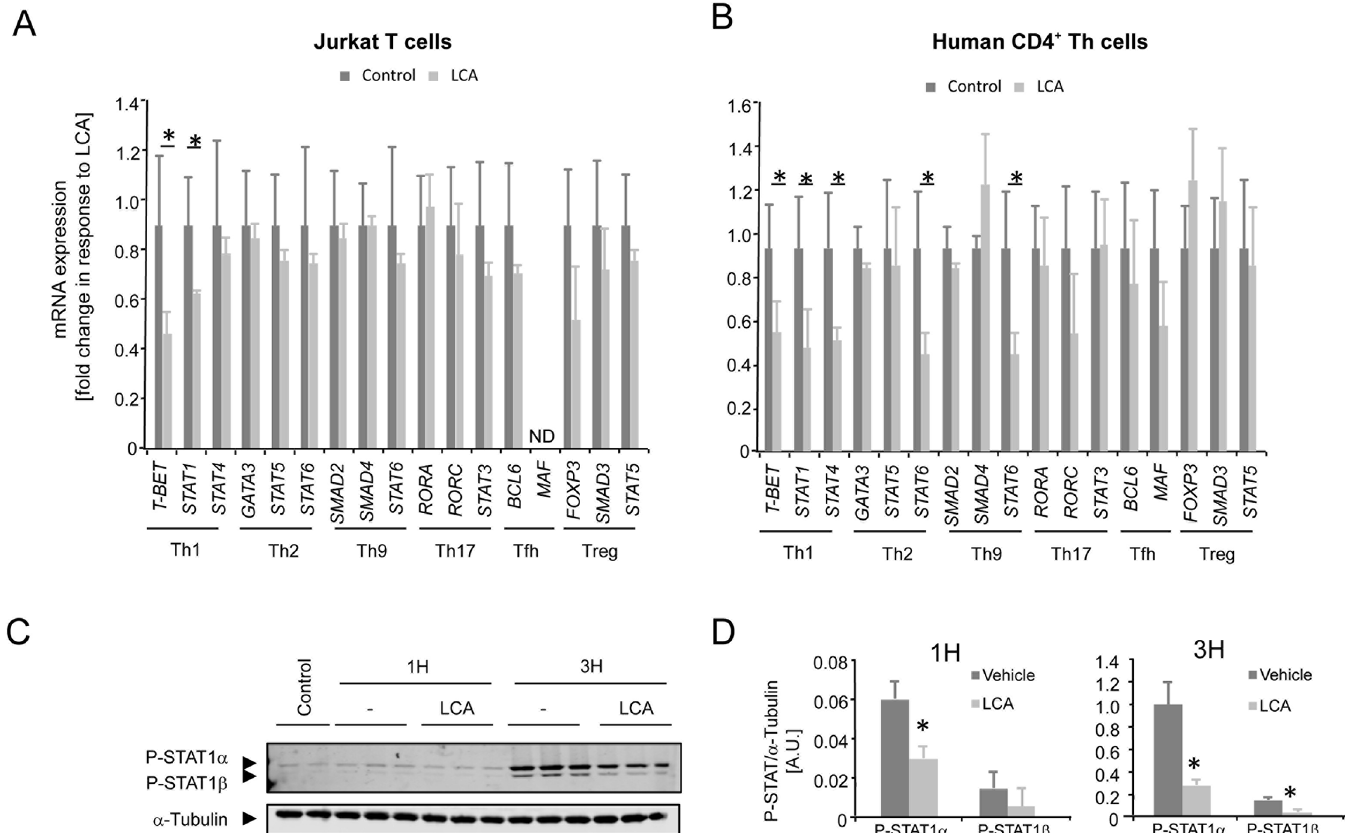
Fig 4. LCA inhibits the Th1 differentiation response of CD4 + Th cells. (A) mRNA expressionin P/I-activated Jurkat T cells and (B) DynabeadsT- activator stimulated primary humanCD4 + Th cells of a panel of genesassociatedwith Th differentiationin responseto 10 μ M LCA treatment. ND; not detected. (C) Western blot images and (D) Quantificationresults of phosphorylated STAT1 α / β and α -Tubulinin Jurkat T cells in response to P/I stimulationin combination with 10 μ M LCA (light grey bars) or vehicletreatment (dark grey bars). LCA, lithocholic acid; P/I, PMA/ionomycin; ND, Not detected; AU, Arbitrary units. Results represent the mean ± SEM. * Statistically significant,P < 0.05. Experiments were performed in triplicatesand repeatedat least twice.